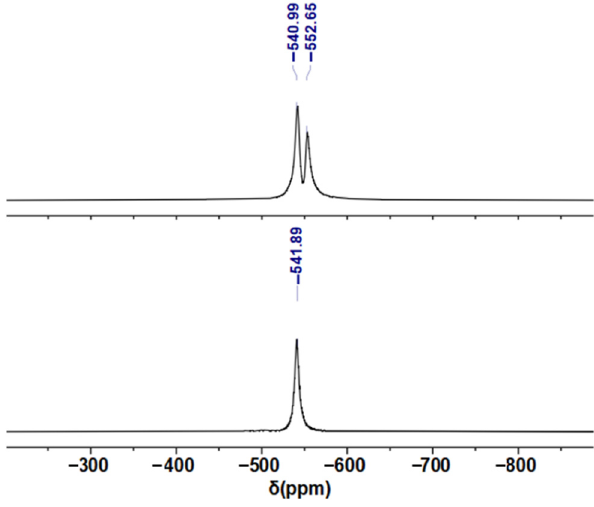
Figure 8. 51 V NMR spectrum of complex 1 in DMSO-d 6 ( a ) and after the addition of 40 equivalent of H 2 O 2 to DMSO-d 6 solution of complex 1 ( b ).